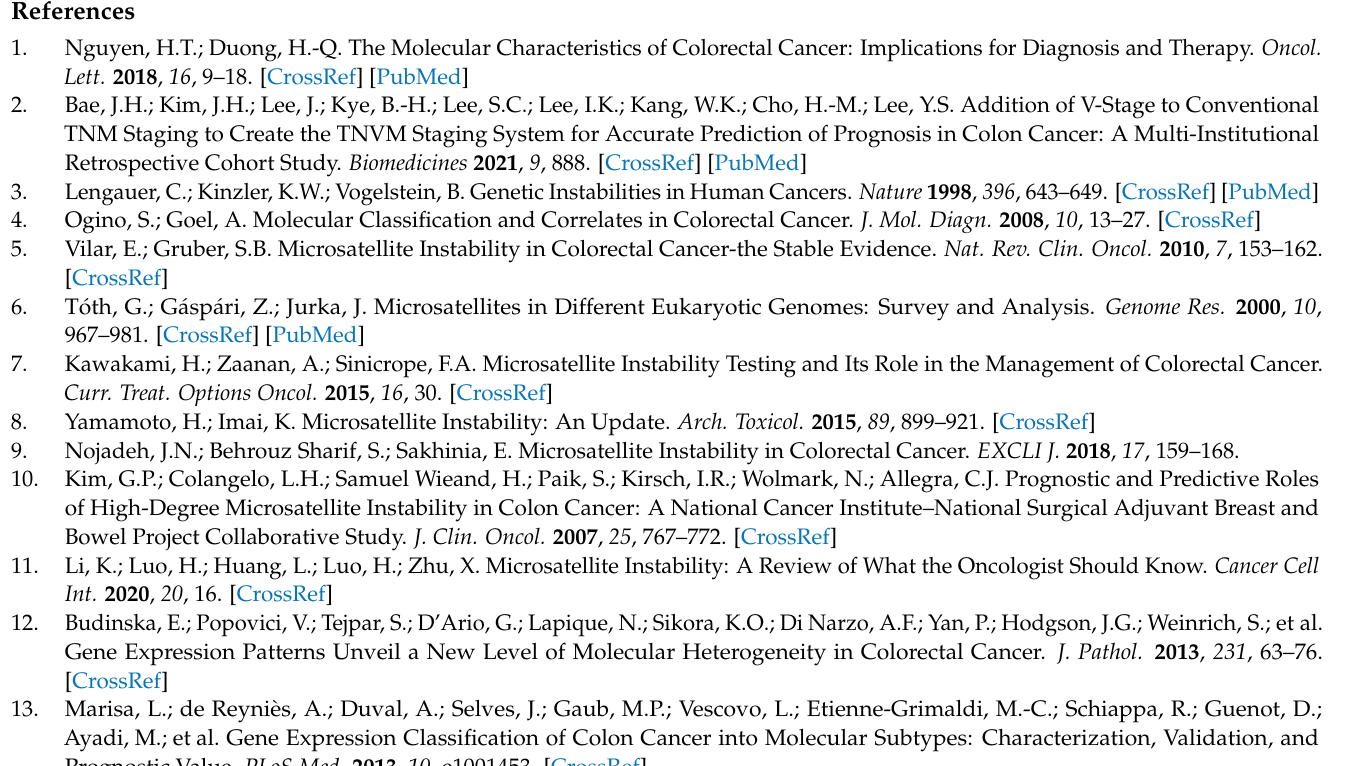
Figure S2: Multivariate COX PH forest plots for OS, Figure S3: Kaplan–Meier survival curves for the Stage_MSI and Stage_CMS systems, Figure S4: Kaplan–Meier survival curves and multivariate COX PH forest plots for OS, Figure S5: Boxplots of the immune, stroma, and microenvironment scores across the five SSCS subtypes, Table S1: 92 dysregulated gene sets between advanced- and early stage of CRC identified from the three cohorts, Table S2: 537 dysregulated gene sets between MSI-H and non-MSI-H cases identified from the TCGA and CPTAC cohorts, Table S3: 94 dysregulated gene sets between early_MSI-H, early_non-MSI-H, advanced_MSI-H, and advanced_non-MSI-H identified from the TCGA and CPTAC cohorts, Table S4: 89 dysregulated gene sets between CMS 1-4 (in early stage) and CMS 1-4 (in advanced-stage) identified from the three cohorts, Table S5: Selected gene subsets for pre-selection, consensus clustering, and classifier building, Table S6: 103 dysregulated gene sets between the five SSCS subtypes, Table S7: Significant tumor-infiltrating cell types associated with DFS and